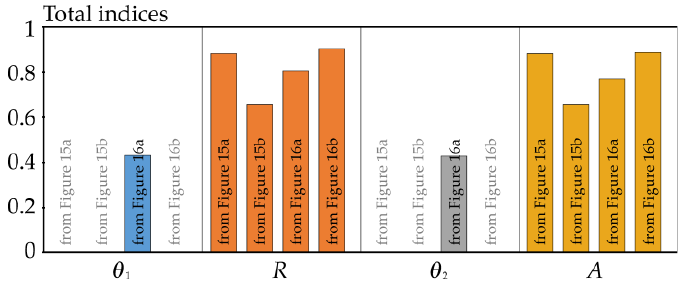
Figure 17. Total sensitivity indices from Figures 15 and 16.